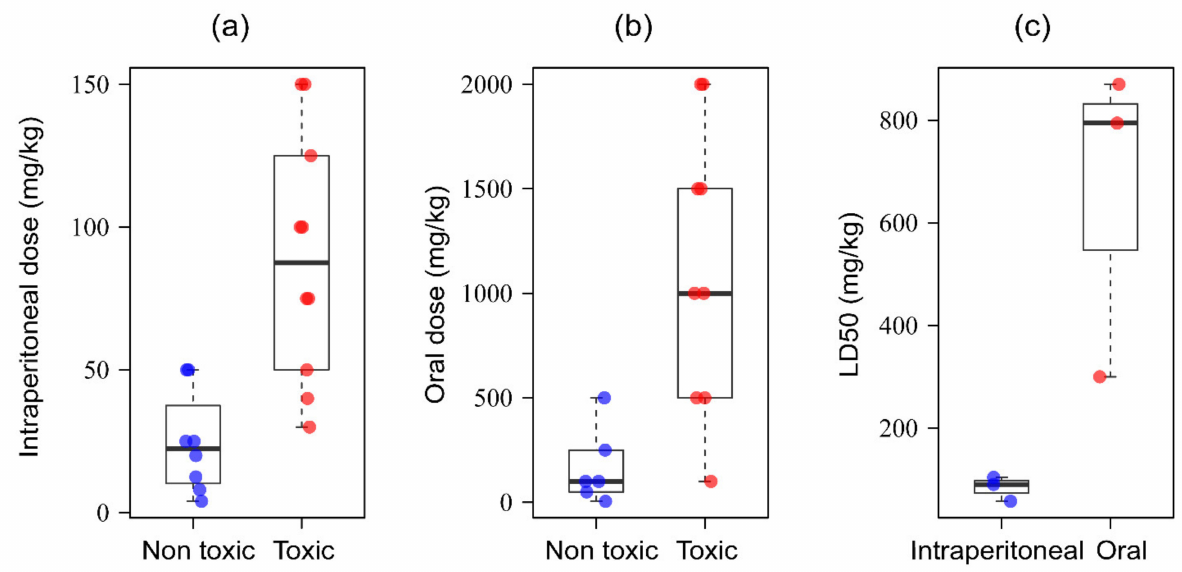
Figure 7. Therapeutic window along with the toxic and lethal dose limit of intraperitoneally and orally administered TQ. ( a ) Toxic ( n = 10) and non-toxic doses ( n = 8) of TQ when intraperitoneally administered in animal models. ( b ) Toxic ( n = 6) and non-toxic doses ( n = 9) of TQ when orally administered in animal models. ( c ) LD50 values of TQ as determined after intraperitoneal ( n = 3) and oral ( n = 3) administration in animal models. n , number of test doses retrieved from ‘n’ number of studies [129,327–329,331–336]. Bold lines indicate medians. Boxes enclose 25th to 75th percentiles. Error bars enclose the data range, excluding outliers. Dots are data points of each tested dose; dots that are vertically outside the error bars are outliers, >1.5 times the interquartile